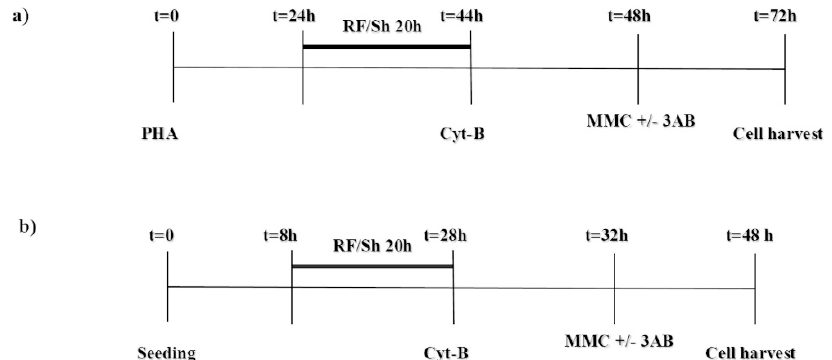
Figure 1. Experimental procedures adopted to treat cell cultures with radiofrequency/sham (RF/Sh) and mitomycin-C (MMC). Timing for 3-aminobenzamide (3AB) treatment (2 mM) is also included. Human peripheral blood lymphocyte (HPBL) treatment: 0.3 W/kg specific absorption rate (SAR); Cytochalasin-B (Cyt-B) 6 µg/mL; MMC 100 ng/mL (panel a ). V79 cell treatment: 1.25 W/kg SAR; Cyt-B 3 µg/mL; MMC 500 ng/mL (panel b ).